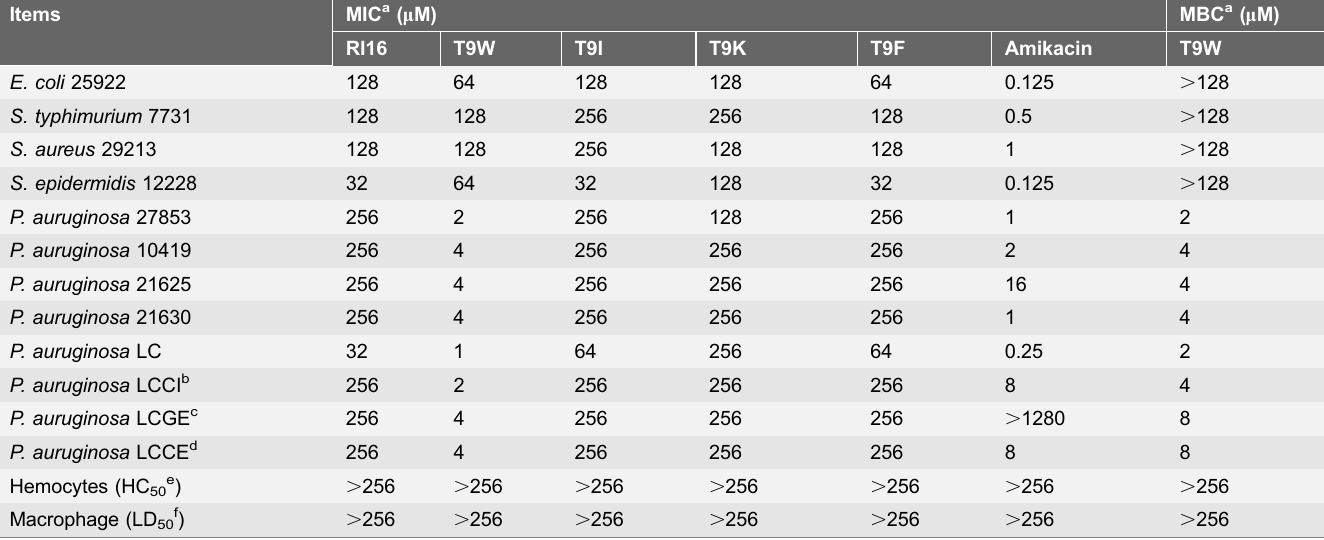
Table 3. Antimicrobial activity and cytotoxic activity of parental and mutant peptides.